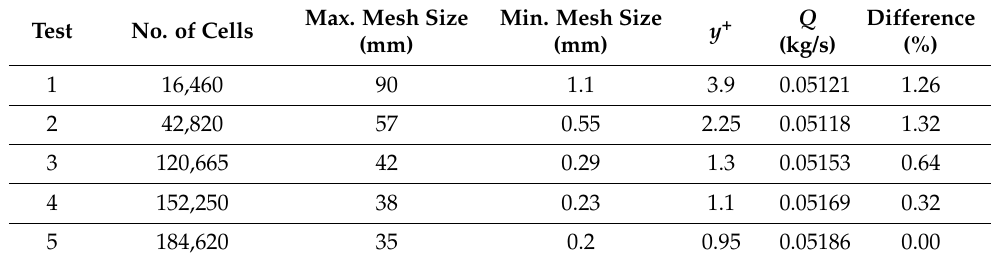
Table 2. Mesh independence